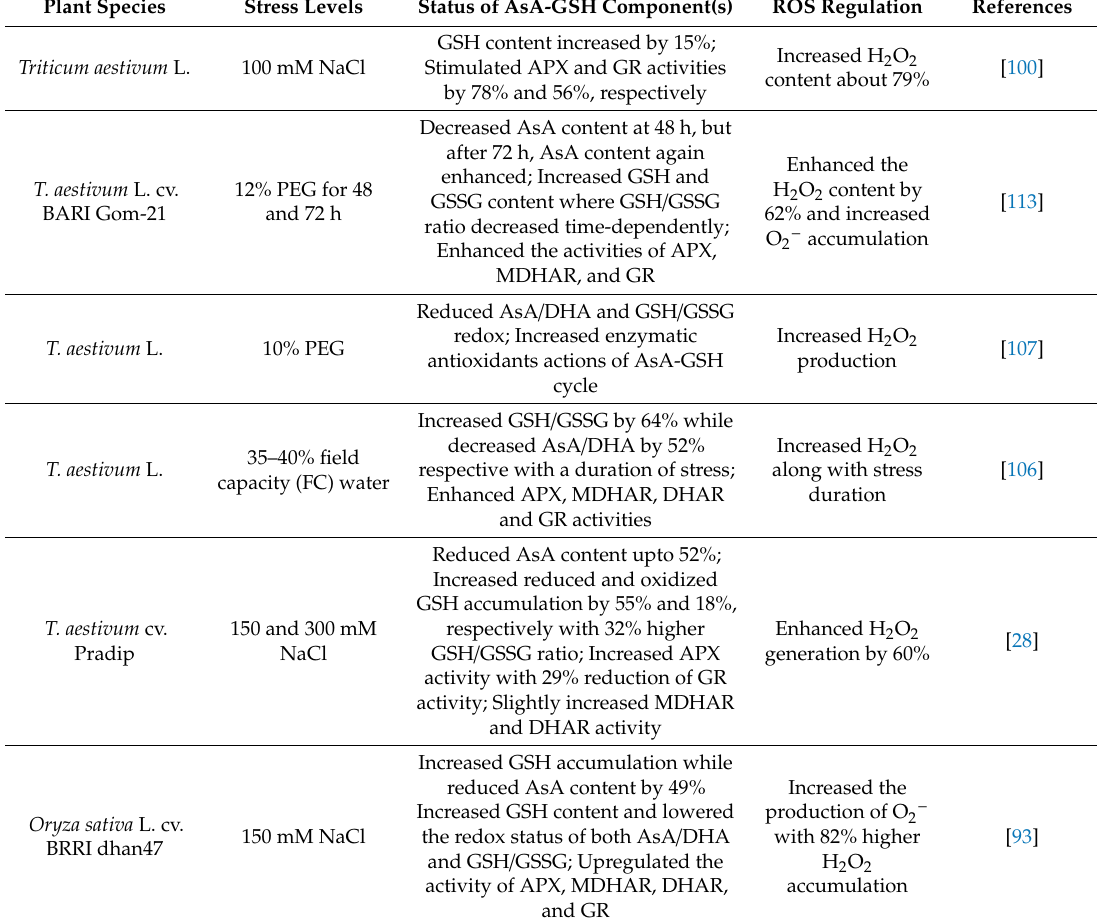
Table 1. Role of AsA-GSH in regulating oxidative stress under salinity and drought. Plant